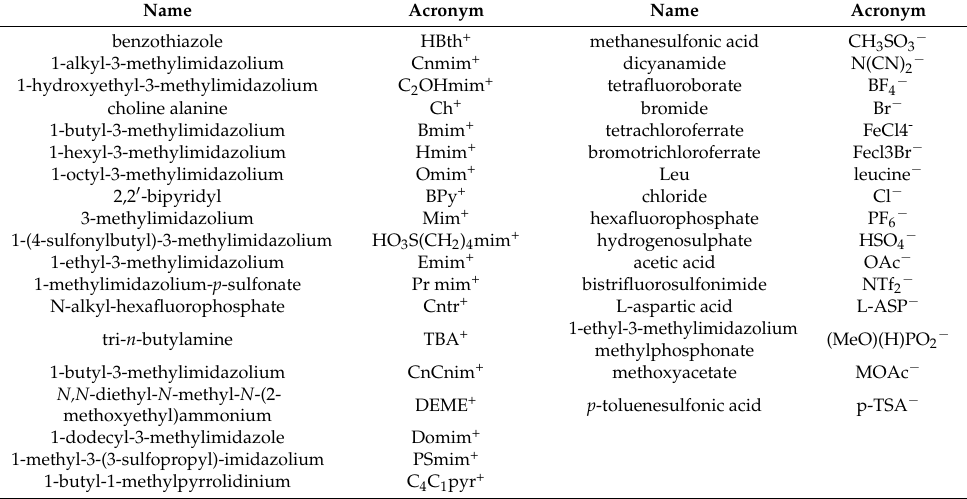
Table 1. Name and respective acronym of the cation-anion combinations in